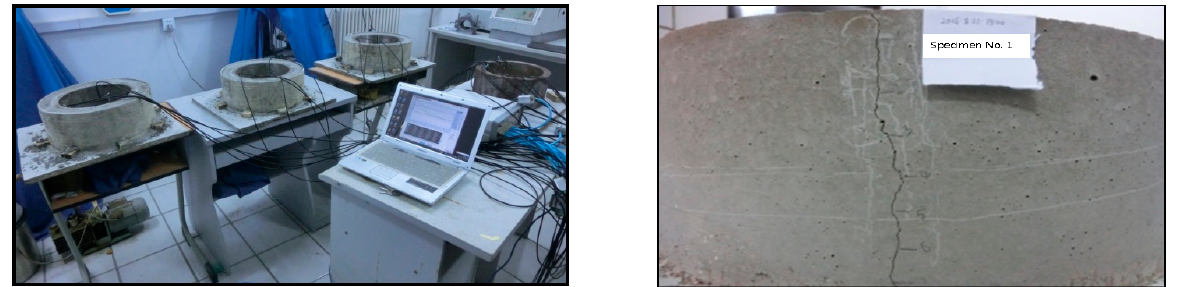
Figure 3. ring test device and surface crack of test